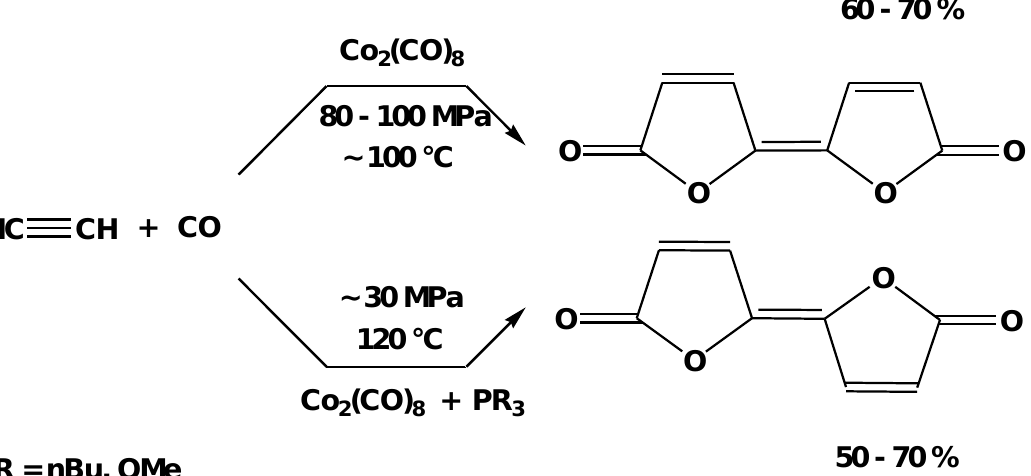
Figure 13. Example of the favorable effect of the PR 3 ligand additive in catalysis: Carbonylation of acetylenes to bifurandiones without [14,16] and with [63–67] additive.